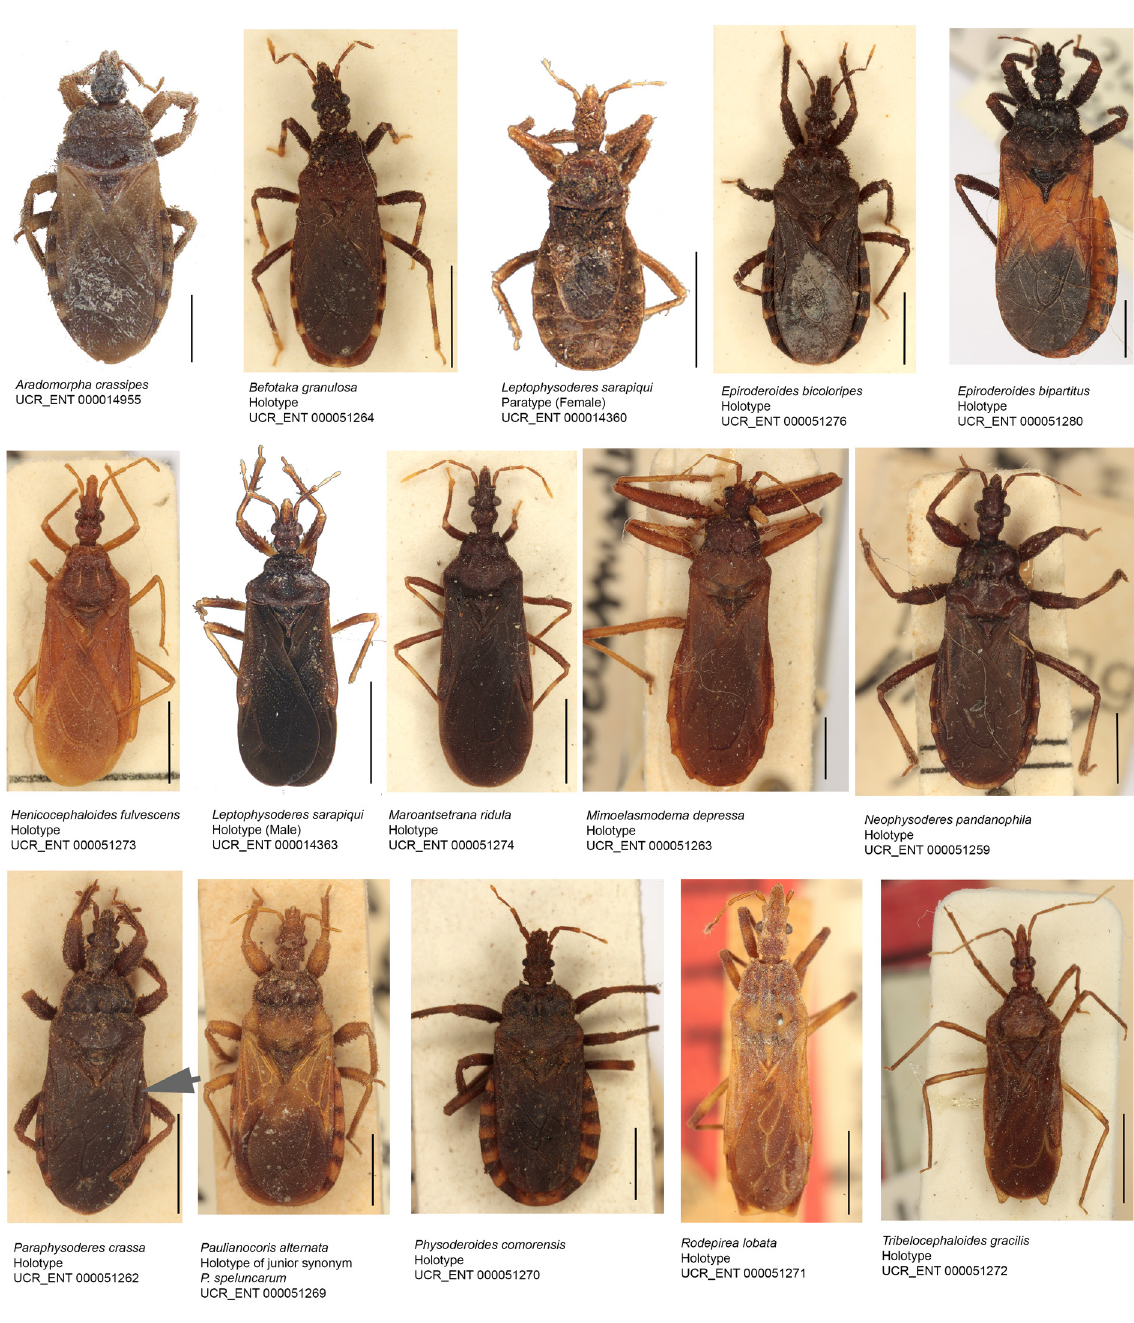
Fig. 3. Dorsal habitus images of other specimens examined for morphological coding. Images by Jean- Michel Berenger, except Leptophysoderes sarapiqui Davranoglou, Hwang & Weirauch, 2015 and Aradomorpha crassipes Champion, 1899. Scale bars = 2